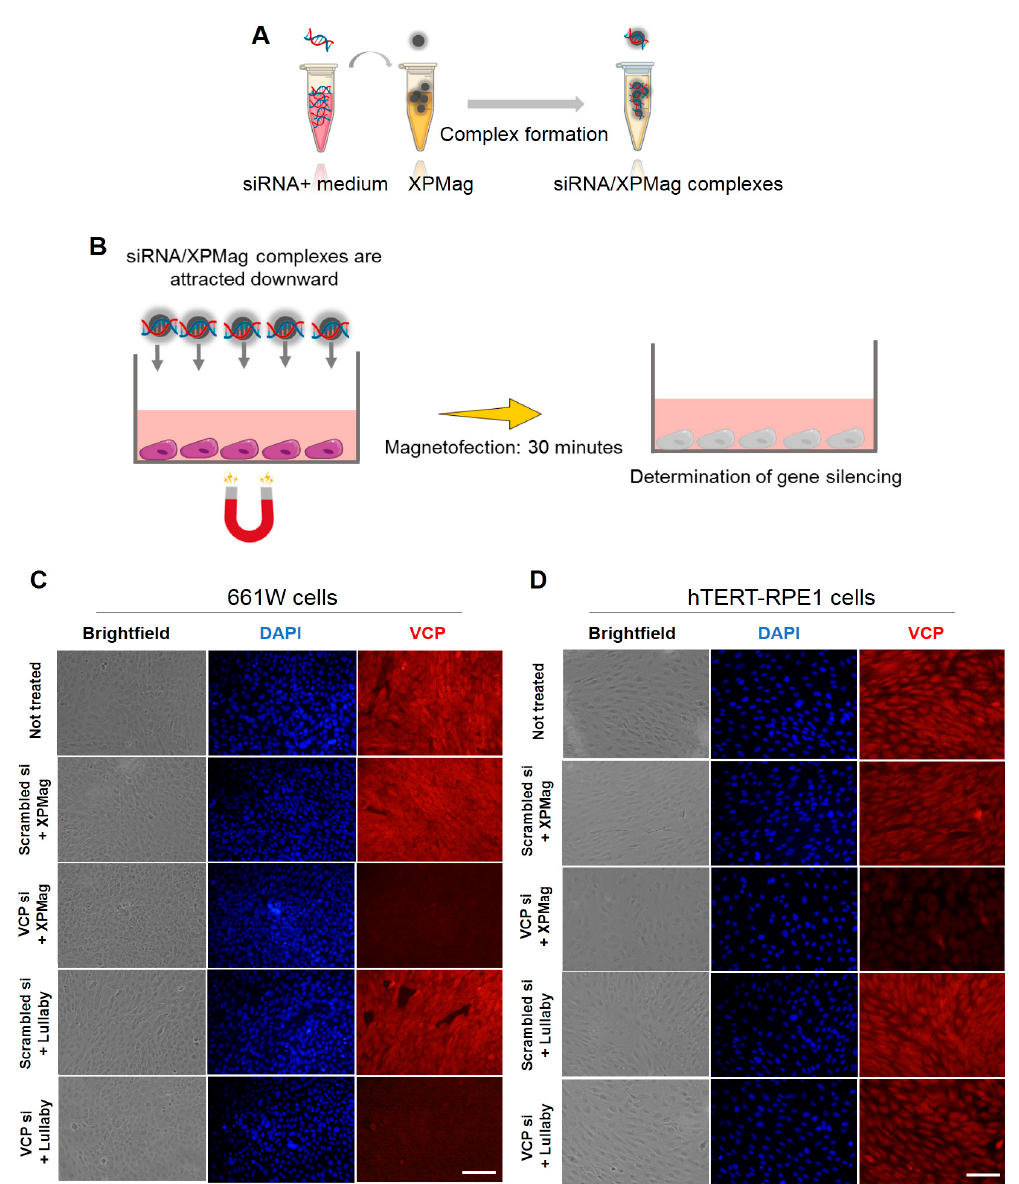
Figure 2. XPMag enhances in vitro VCP silencing in mouse retinal 661W and human hTERT-RPE1 cells by forming complexes with VCP siRNA via classic Magnetofection. ( A , B ) Illustration of the classic Magnetofection technique used for transfection of siRNA. First, siRNA is added to XPMag MNPs, followed by an incubation time of 30 min to allow the correct formation of MNPs/siRNA complexes ( A ), then the complexes are added to the medium of the cell culture model and then attracted towards the cells by placing a magnet under the culture plate during 30 min for classic Magnetofection ( B ). The siRNA transfection was assessed 48–72 h after treatment. Representative images of VCP expression (red) and cell nuclei with DAPI (blue). Classic Magnetofection using 2 µ L XPMag and 25 nM VCP siRNA showed unaltered cell monolayer integrity and a considerable decrease in VCP signal intensity in treated mouse retinal 661W cells at 72 h ( C ) and human hTERT- RPE1 cells after 48 h ( D ). Lullaby complexed with VCP siRNA was used to compare the efficiency of lipofection with Magnetofection. Magnetofection of scrambled siRNA complexed with XPMag and XPMag alone were used as negative control groups. Scale bar 200 µ m. Abbreviations: VCP si: VCP siRNA, Scr si: scrambled